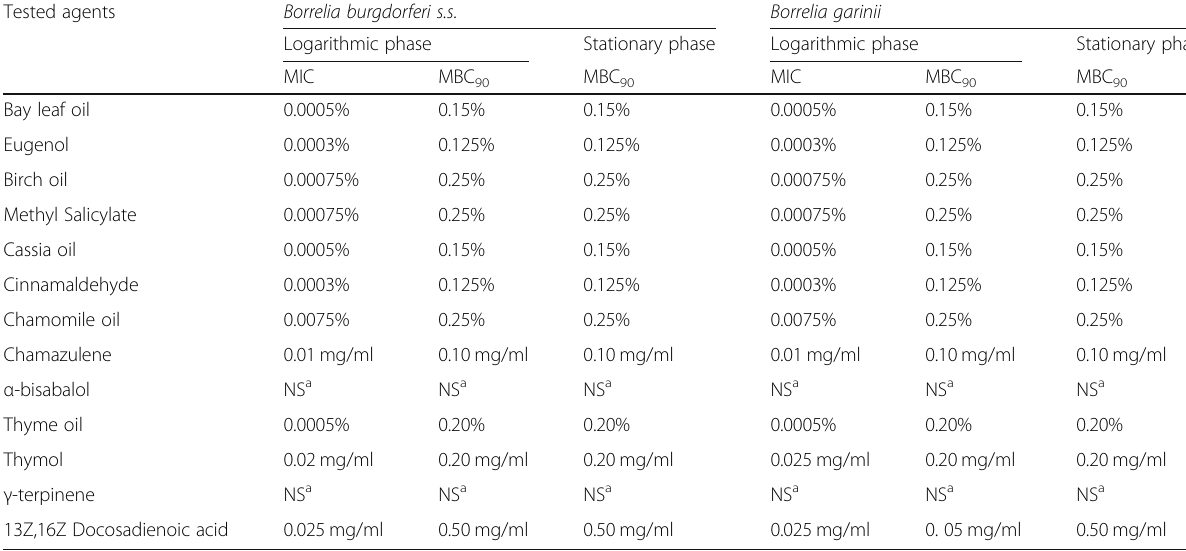
Table 3 Bacteriostatic and bactericidal efficacy of selected lipids and its active components against logarithmic and stationary phases of Borrelia burgdorferii s.s. and Borrelia garinii Tested